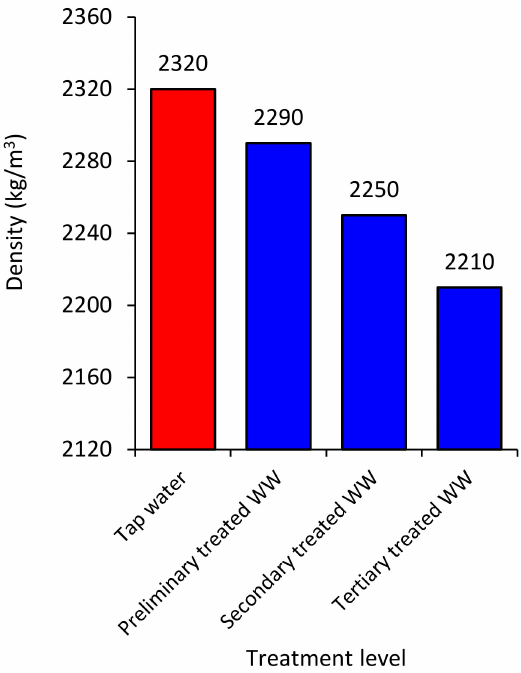
Figure 15. Average effect of different WW types on the relative density of concrete [14,19,24,39].